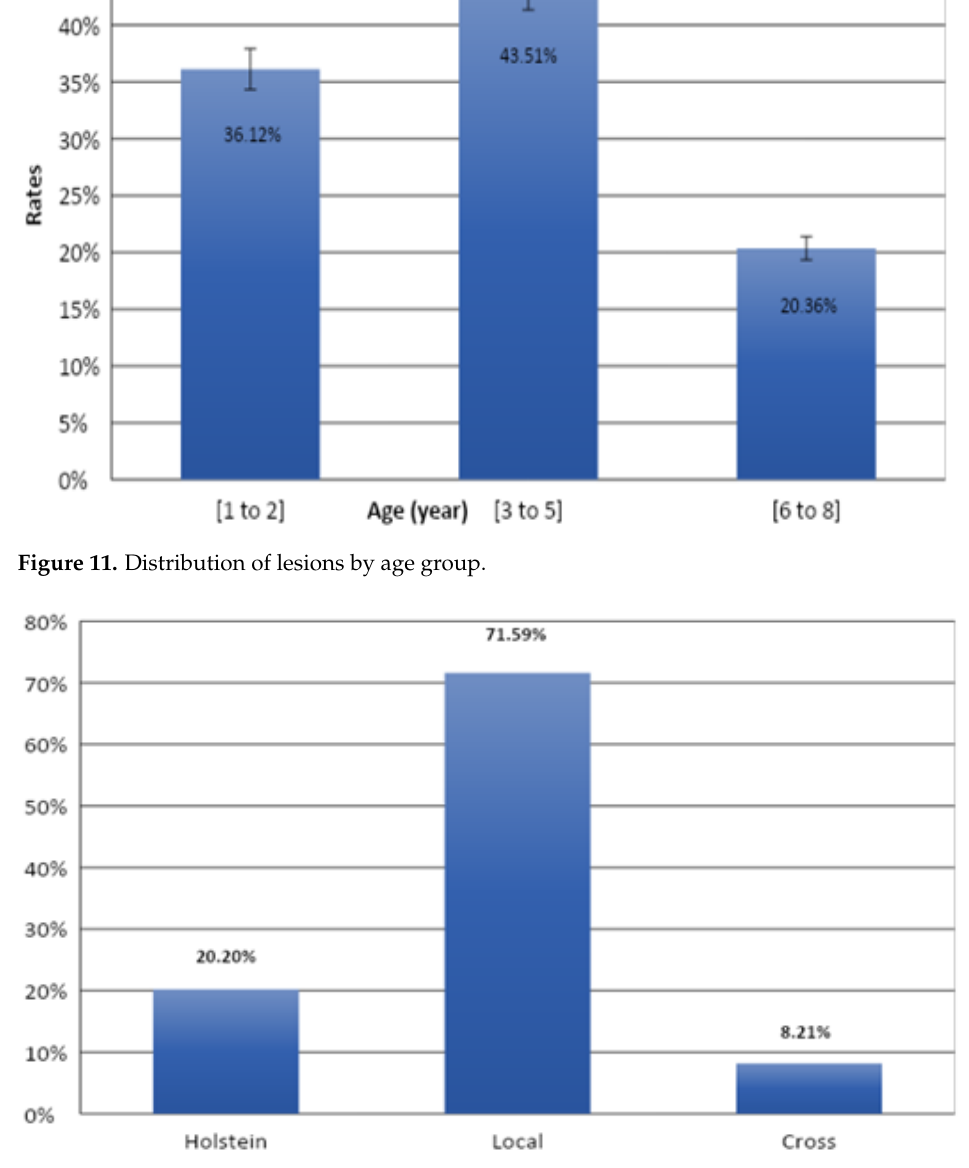
Figure 12. Distribution of lesions by breed.